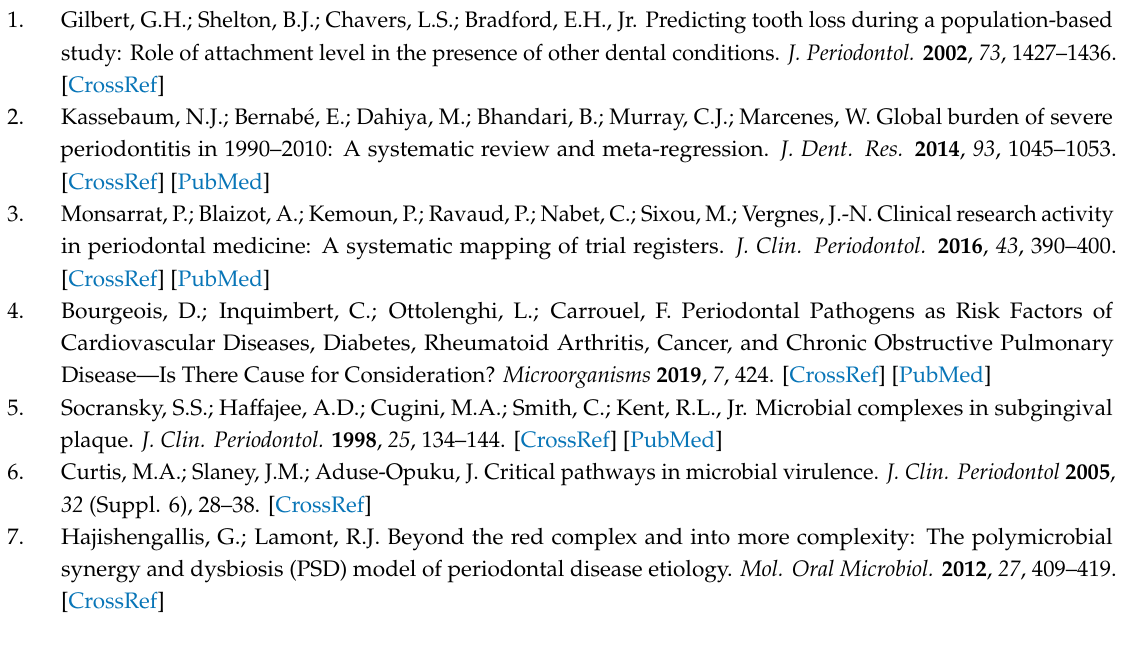
Clinical and bacterial findings in selected sites before groups; Table S3: Periodontal clinical parameters according to the psychosocial context of control patients, Figure S2: Correlation between total microbiota count from pathological sites and cortisol concentrations in diseased patients, Table S4: E ff ect of stress and anxiety on the detection of periodontal bacteria before and after SRP treatment from diseased